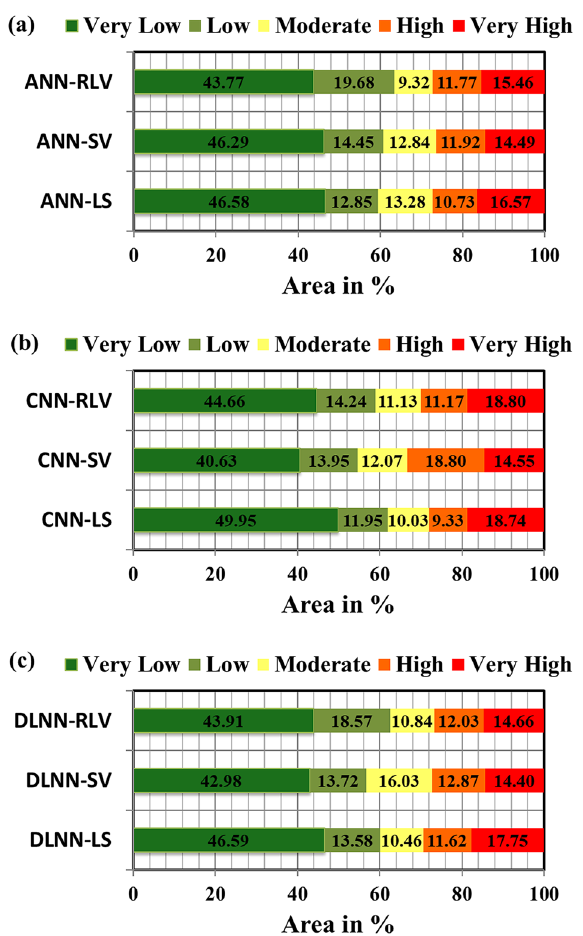
Figure 10. Distribution of physical, social and relative vulnerability classes produced using three